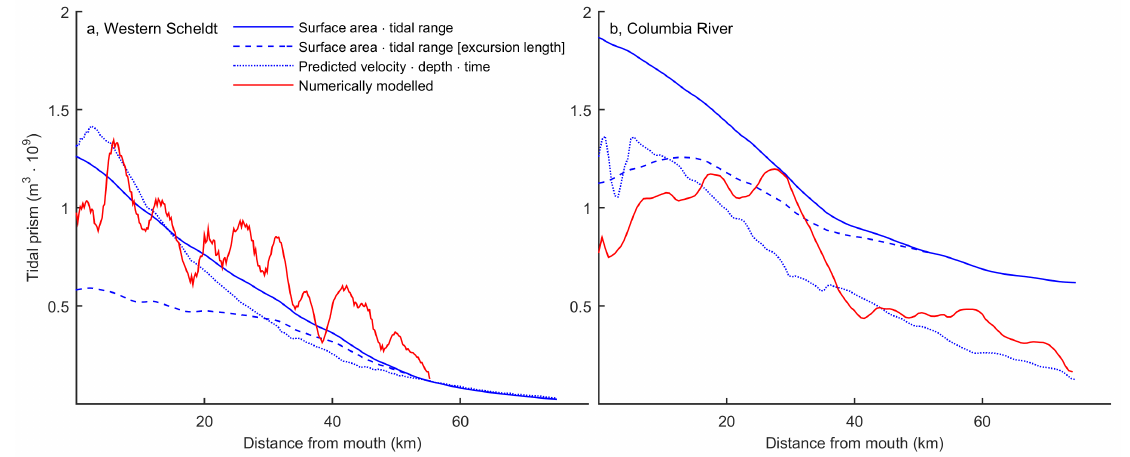
Figure 10. Resulting predictions of local tidal prism for the Western Scheldt ( a ) and Columbia River ( b ). Red lines are model results, blue lines are tool